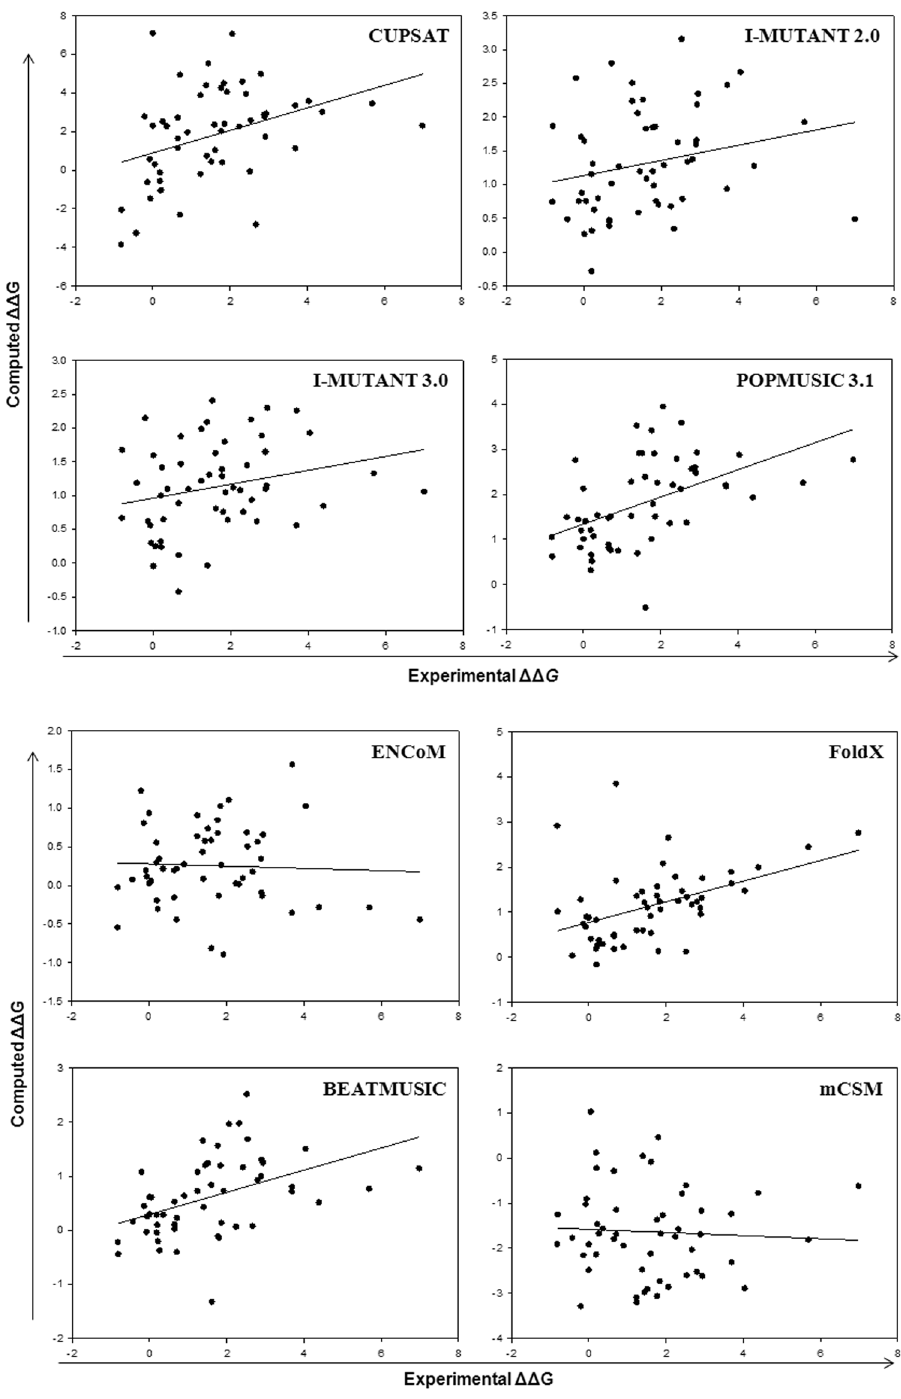
Figure 1. Correlation between experimental monomer and computed stability changes, ΔΔ G (kcal/mol) for 54 mutants using 2C9V and eight